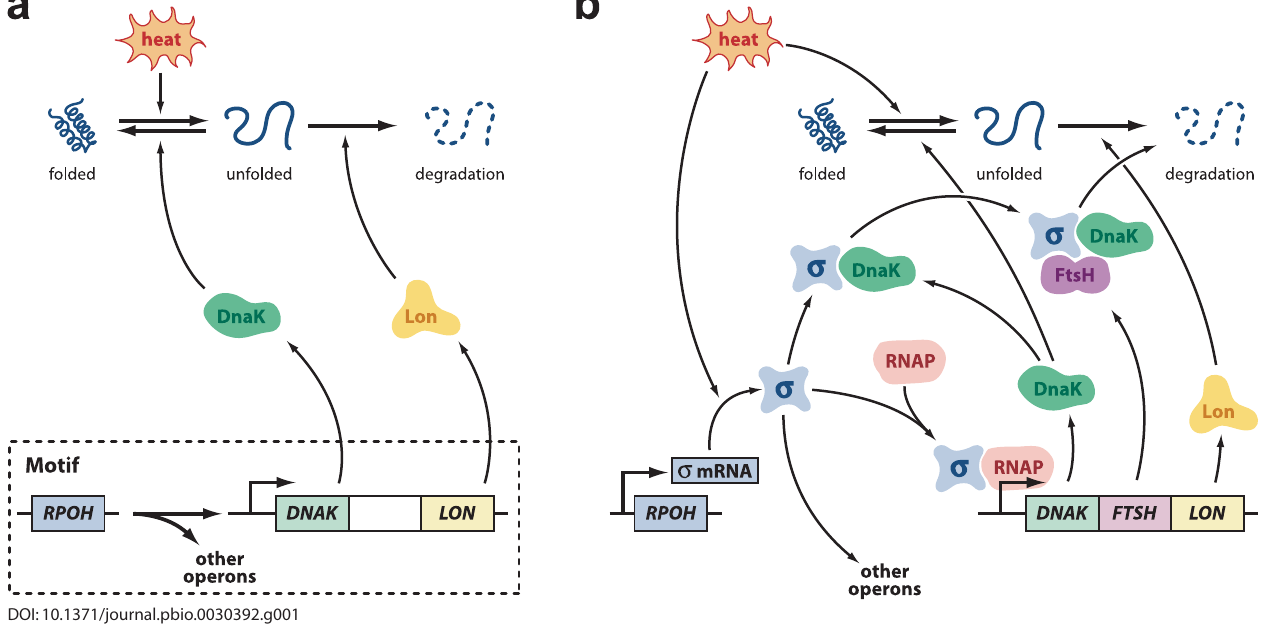
Figure 1. Cartoons of the Escherichia coli HS Control System (A) The transcriptional motif showing its basic function, the manufacture of chaperones to refold and proteases to degrade denatured proteins. For simplicity, only one operon is shown in detail. (B) The same network including control elements. See text for